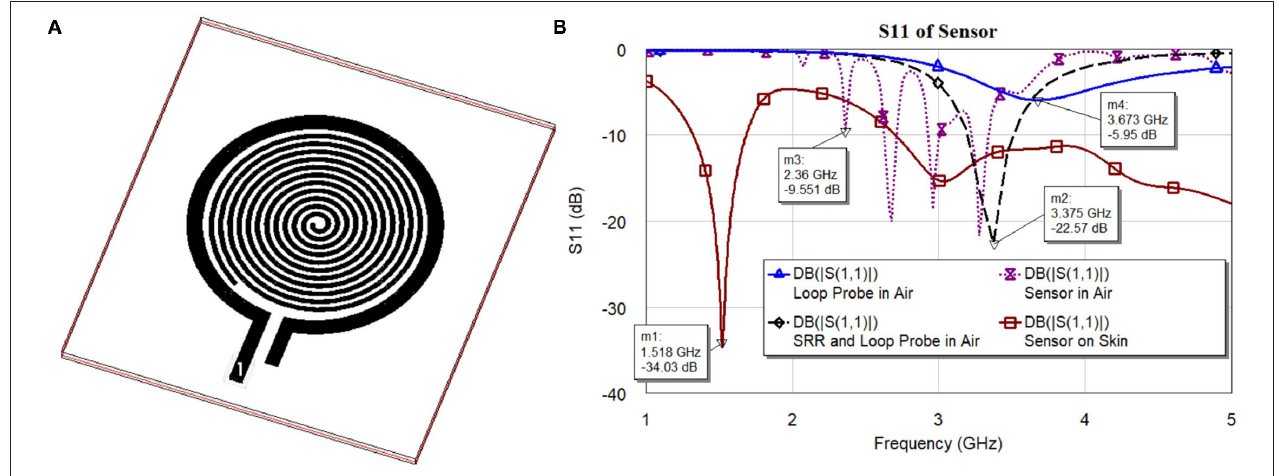
FIGURE 2 | (A) 3D Orthogonal view of the sensor and (B) S 11 characteristics of the sensor and its elements.